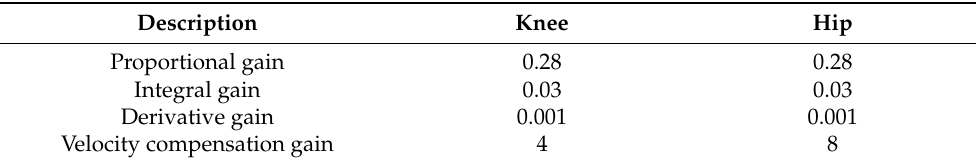
Table 3. PID gains and velocity compensation